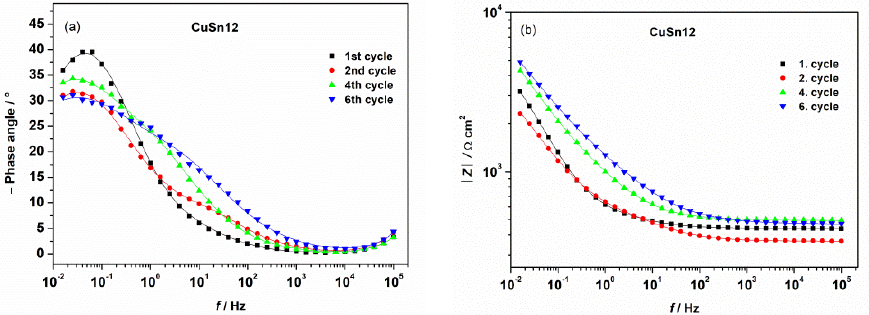
Figure 5. EIS spectra for CuSn12 for alternating wet/dry cycles in simulated acid rain at pH 5. ( a ) Bode phase angle; ( b ) Bode impedance. Table 5. EIS data for CuSn12 for alternating wet/dry cycles in simulated acid rain at pH 5.